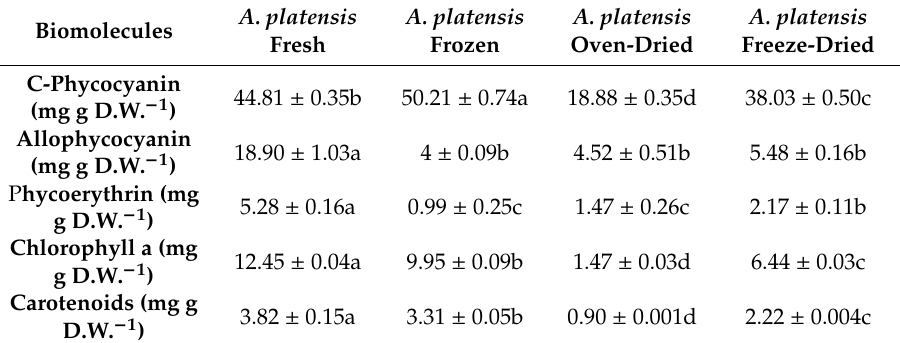
Table 1. The pigments content in A. platensis biomass fresh and di ff erently